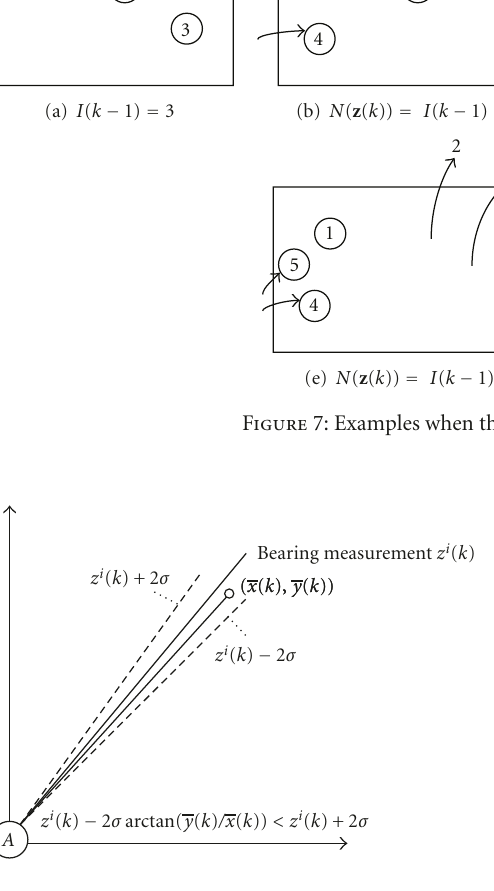
Figure 8: 95% confidence true bearing ranges-based triggering